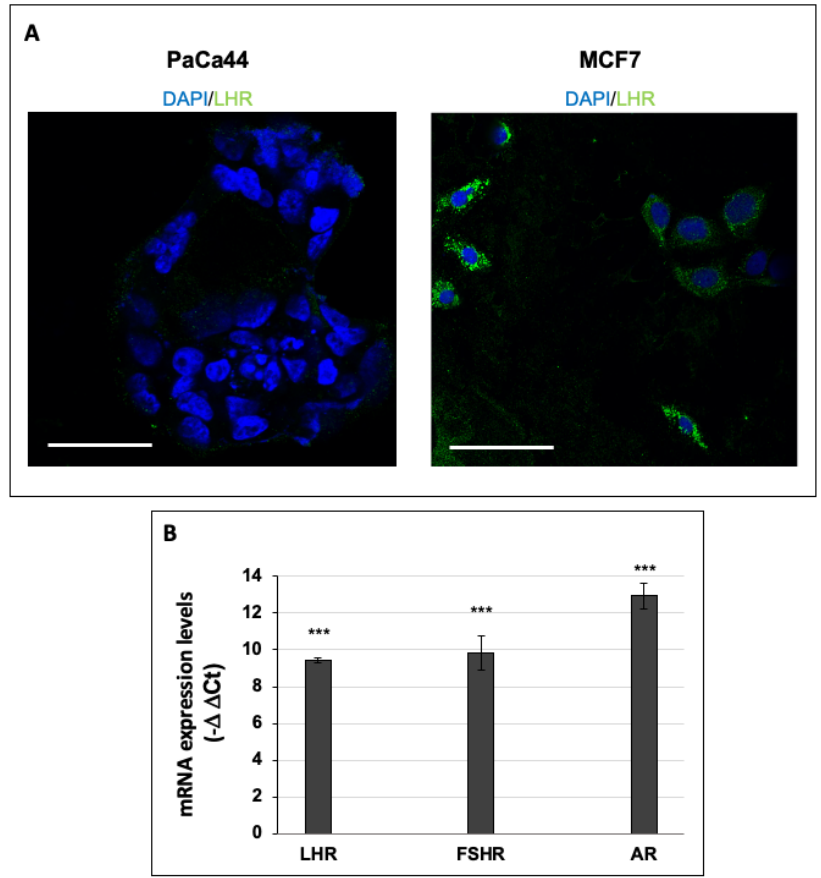
Figure 1. ( A ) Representative immunofluorescent images of luteinizing hormone receptor (LHR) expression in PaCa44 and MCF7 cells. Scale bar: 50 µ m. ( B ) mRNA expression levels of LHR, follicle-stimulating hormone receptor (FSHR), and AR expressed as “–delta delta Ct” values in relation to the housekeeping gene expression levels (RpLp0) in MCF7 cells relative to the pancreatic ductal adenocarcinoma cell line PaCa44, used as a control. Values are the means ( ± SD) of three independent biological replicates. Statistical legend: p < 0.001 (***) for MCF7 cells relative to PaCa44 cells.